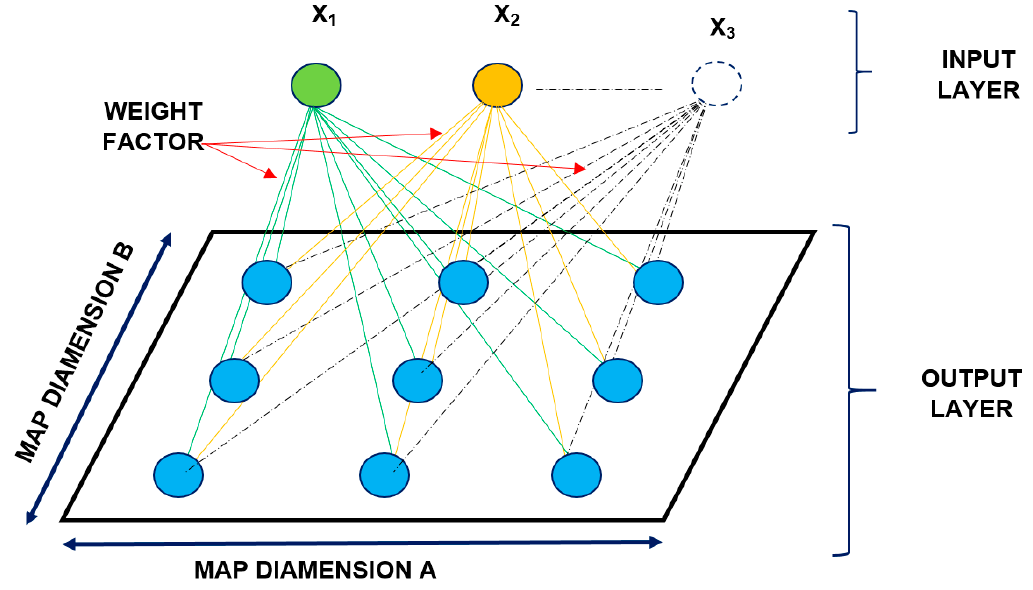
Figure 4. Scheme of the Kohonen’s neural network (own elaboration based on [65]).